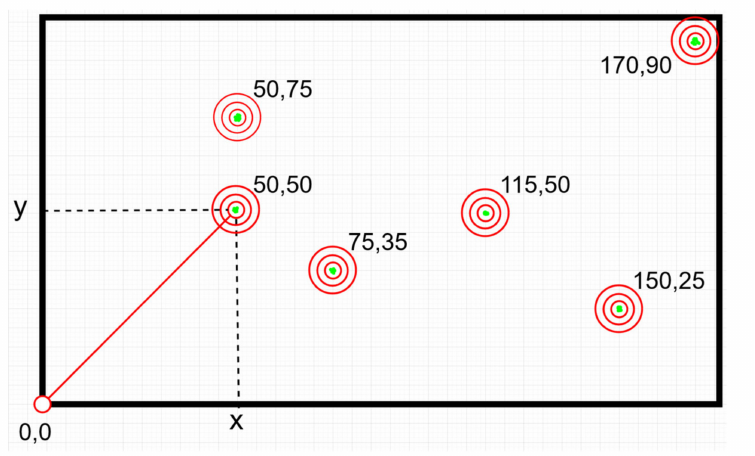
Figure 21. 2D schematic representation of the set paths. The green dots represent the pen marks. In some cases the dots are less than 10 due to overlap between them. Table 5. Repeatability and accuracy test